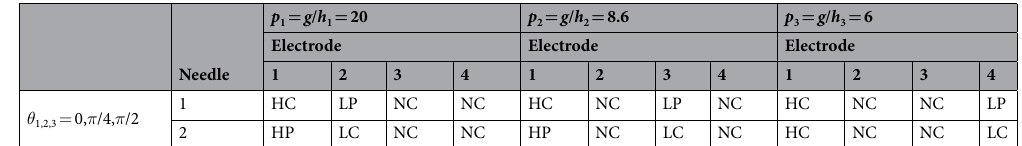
Table 2. Experimental configuration employed for in situ experiments based on method S1. We measured the apparent impedivity in D = 3 directions, i.e. θ 1,2,3 = 0, π /4, π /2. For each direction, N = 3 inter-electrodes’ distances, i.e. h 1,2,3 = 1.5, 3.5, 5 mm, were measured with the needle electrodes’ distance center to center being g = 30 mm. Electrodes’ abbreviation: HC, high (source) current; HP, high (positive) potential; LP, low (negative) potential; LC, low (sink) current; NC, not